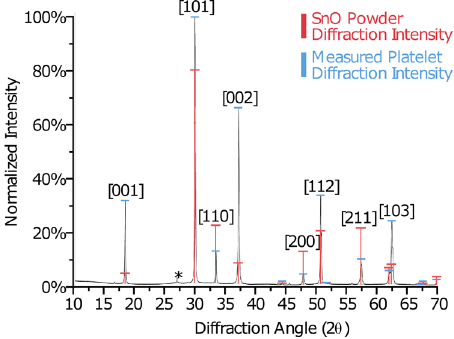
Fig. 6 Labelled X-ray diffraction pattern of synthesized SnO platelets, alongside comparison to typical relative peak intensi- ties for SnO powder (normalized by the integral signal intensity of the sample). The normalized intensity is given with respect to the [101] peak. The asterisk indicates an equipment